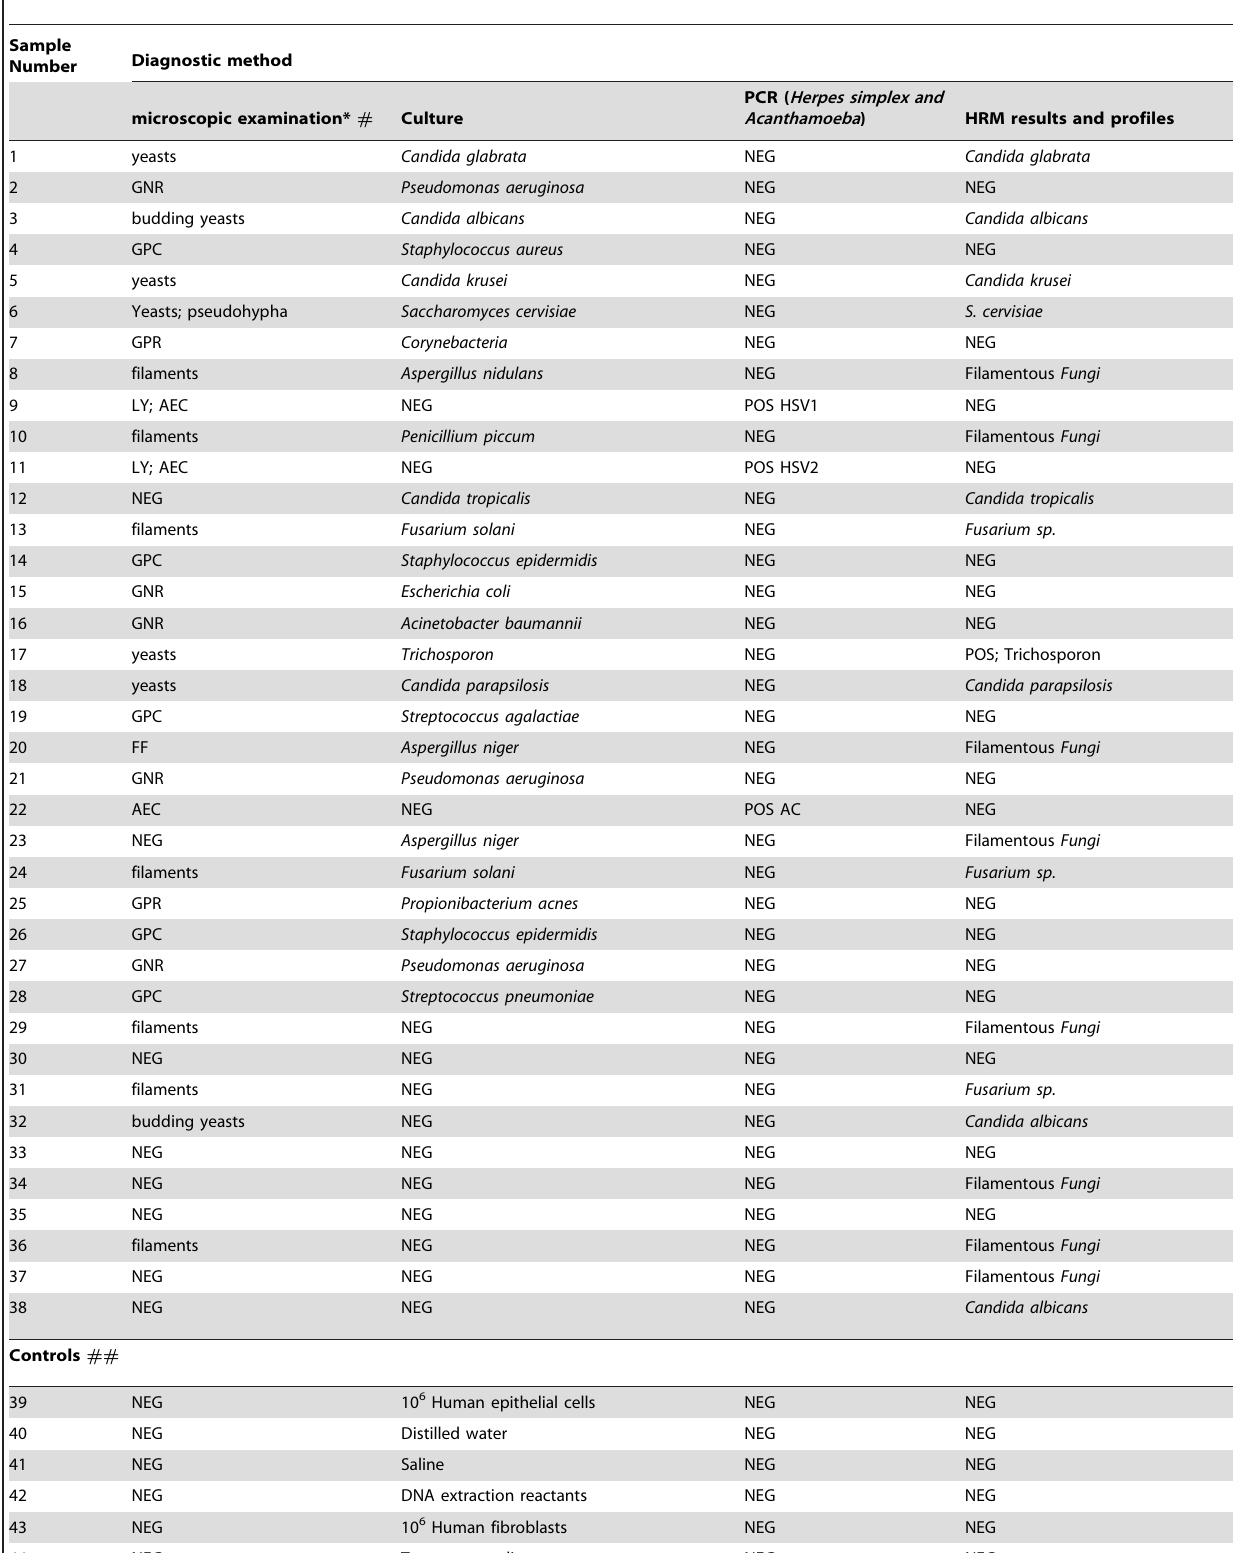
Table 2. Comparison of direct microscopic examination, culture and high-resolution melting analysis performances (PCR-HRM) on corneal scrapings obtained from patients with